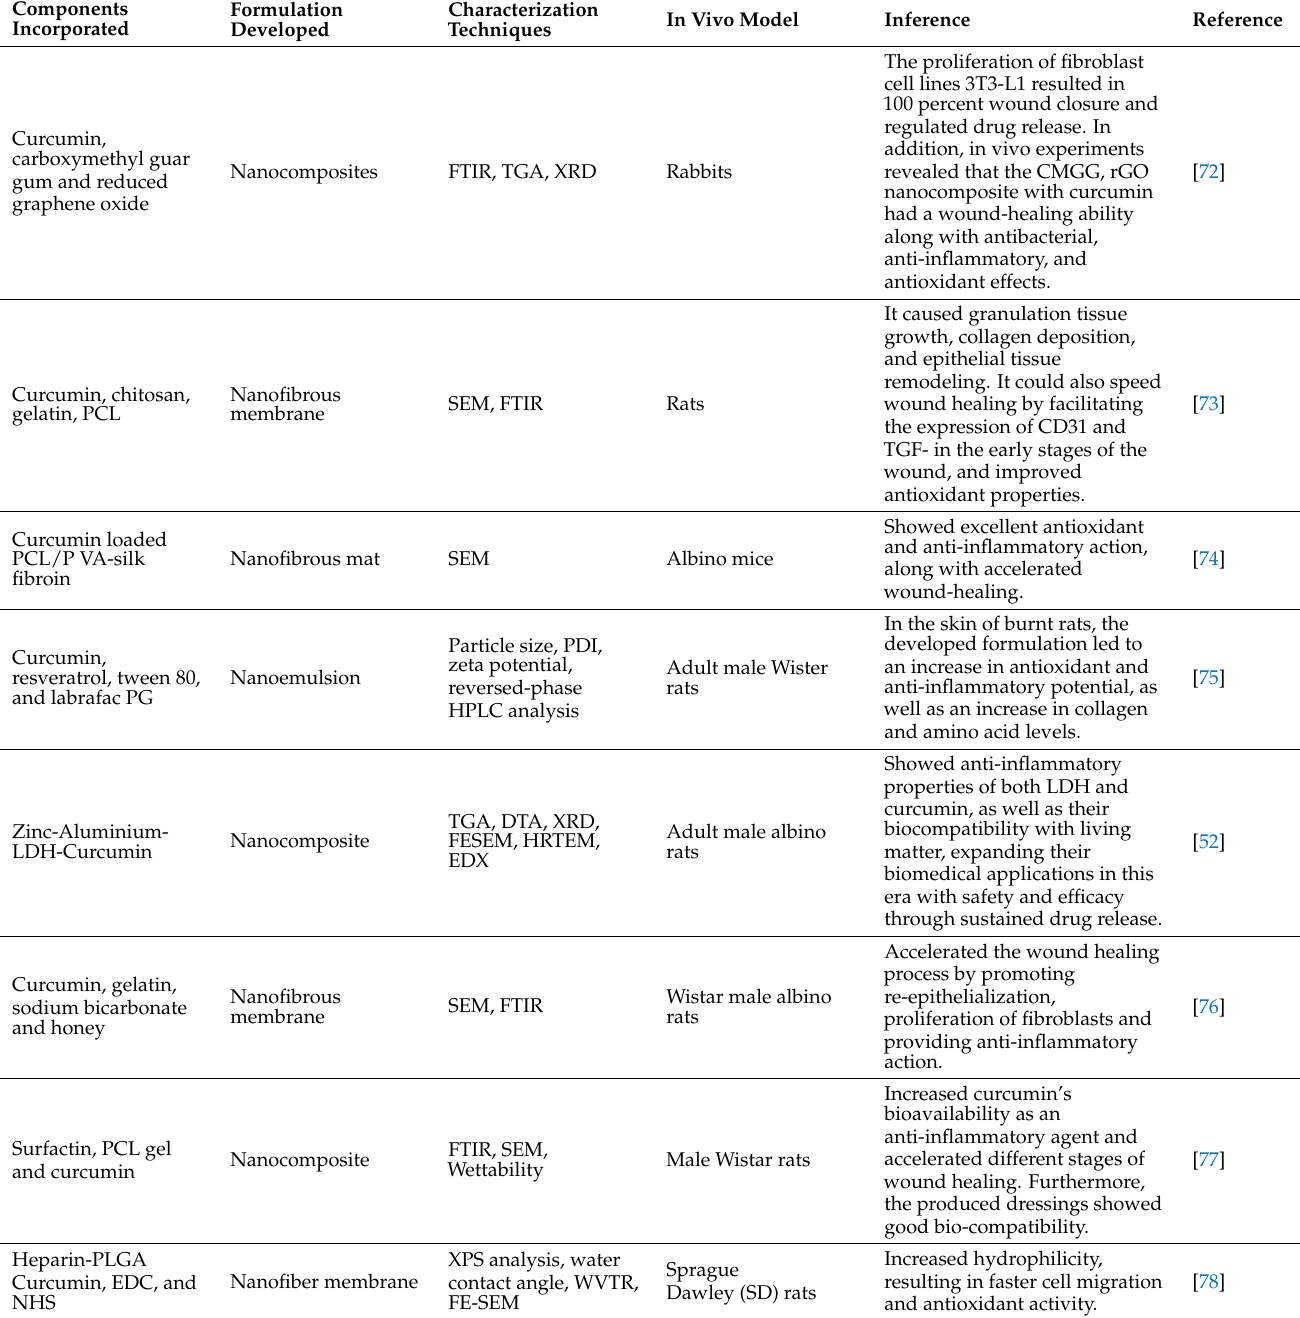
Table 1. Recent research studies on curcumin-loaded nanoformulations for the treatment of